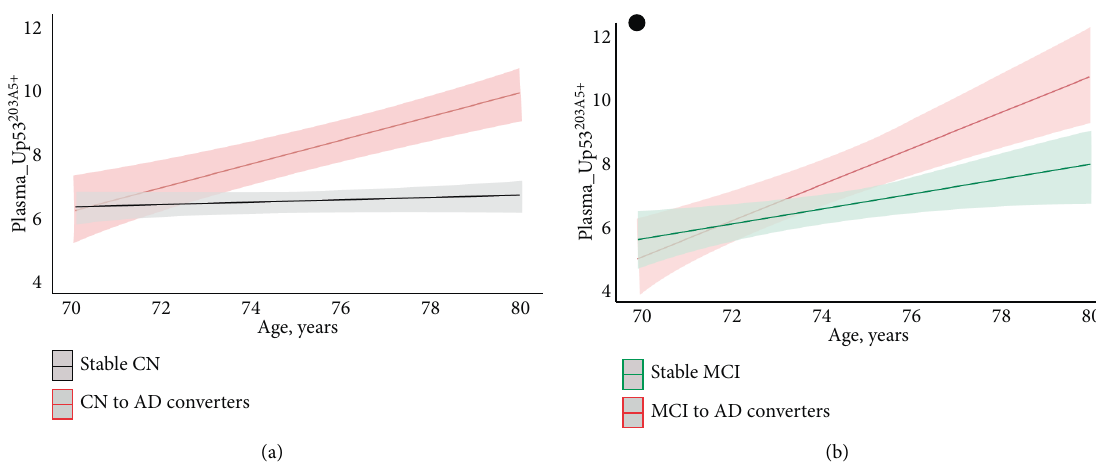
Figure 5: (a) Levels of unfolded-p53 increase with age, which promotes AD. (b) The level of U-p53 in stable MCI, where the levels of U-p53 do not increase as much as they increase in AD